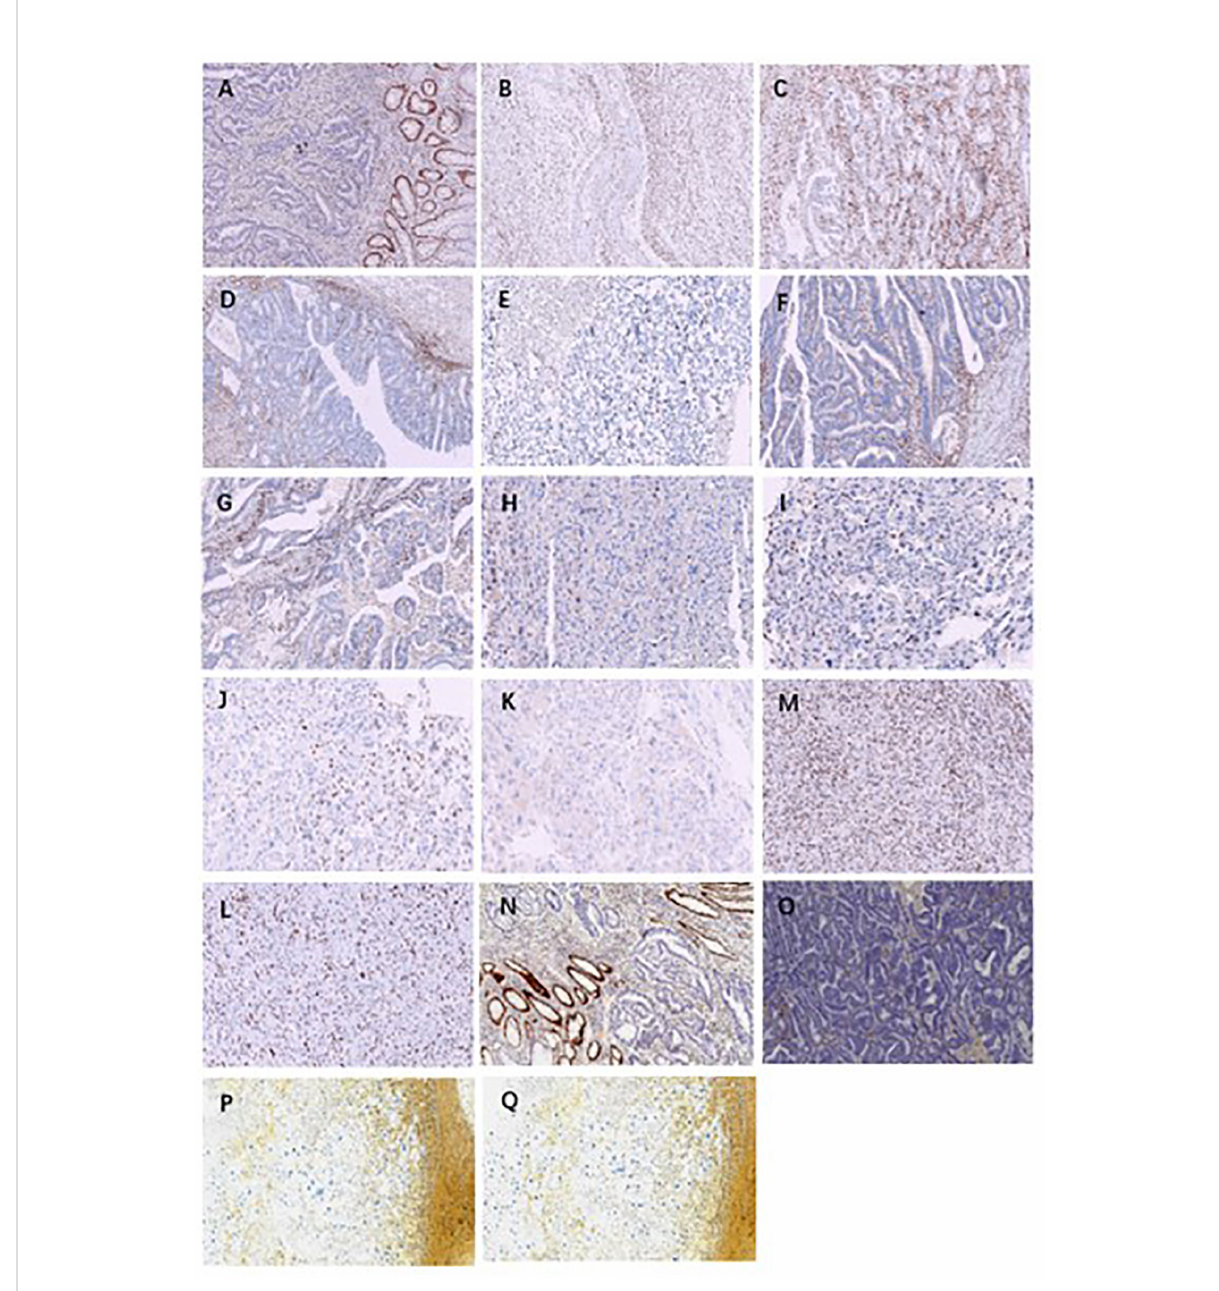
FIGURE 2 Immunohistochemical staining of cases 1-4. (A) : case 1 rectal moderately differentiated adenocarcinoma MSH6 expression loss; (B) : Case1 pelvic uterine clear cell carcinoma MSH6 expression loss; (C) : Case1 metastatic clear cell carcinoma of the uterus in the right lower abdomen MSH6 expression loss; (D) : Case2 well differentiated intramucosal carcinoma of transverse colon MSH6 expression loss; (E) : Case2 poorly differentiated carcinoma of bladder MSH6 expression loss; (F) and (G) : Case3 moderately differentiated adenocarcinoma of rectum MSH2 and MSH6 expression loss; (H) and (I) : Case3 adrenocortical carcinoma MSH2 and MSH6 expression loss; (J) and (K) : Case3 Abdominal metastatic adrenocortical carcinoma MSH2 and MSH6 expression loss; (M) and (L) : Case3 pleomorphic sarcoma of right chest wall MSH2 and MSH6 expression loss; (N) and (O) : Case4 moderately differentiated adenocarcinoma of colon MSH2 and MSH6 expression loss; (P) and (Q) : Case4 histiocytic sarcoma of the right upper arm MSH2 and MSH6 expression